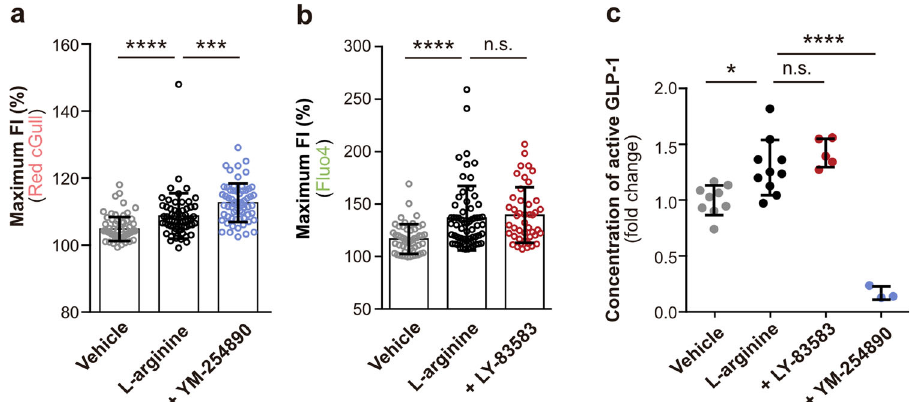
Fig. 6 Interplay between Ca 2 + and cGMP, and their effect on GLP-1 secretion in STC-1 cells. a Maximum FI of Red cGull with the application of 10 mM L - arginine in the presence of 250 nM YM-254890. Data were means ± s.d. (vehicle: n = 72 cells from four independent experiments; L -arginine: n = 60 cells from four independent experiments; + YM-254890: n = 62 from four independent experiments). Kruskal – Wallis test with Dunn ’ s multiple comparisons. From left to right: p < 0.0001 (****), p = 0.0005 (***). b Maximum FI of Fluo4 during the application of 10 mM L -arginine in the presence of 1 μ M LY- 83583. Data were means ± s.d. (vehicle: n = 51 cells from four independent experiments, L -arginine: n = 64 cells from four independent experiments; + LY- 83583: n = 45 cells from four independent experiments). Kruskal – Wallis test with Dunn ’ s multiple comparisons. From left to right: p < 0.0001 (****), p > 0.9999 (n.s.). c Results of ELISA showing the concentration of GLP-1 secreted by STC-1 cells after the application of 10 mM L -arginine in the absence or presence of each inhibitor. Data were means ± s.d. One-way ANOVA with Tukey ’ s multiple comparison test (vehicle: n = 9 wells, L -arginine: n = 10 wells, + LY-83583: n = 5 wells, + YM-254890: n = 3 wells). From left to right: p = 0.0103 (*), p = 0.5639 (n.s.), p < 0.0001 (****).